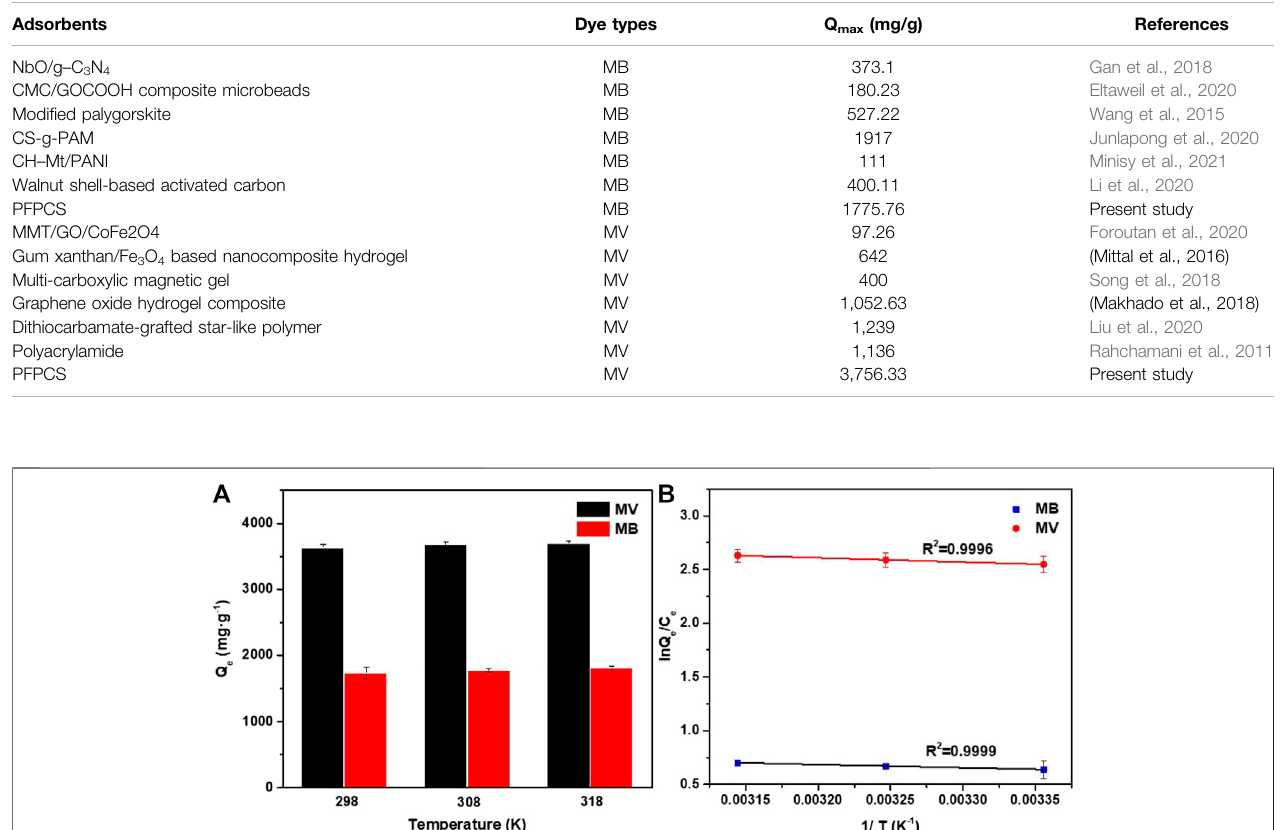
TABLE 4 | Comparison of adsorption capacity of PFPCS with other adsorbents reported previously.